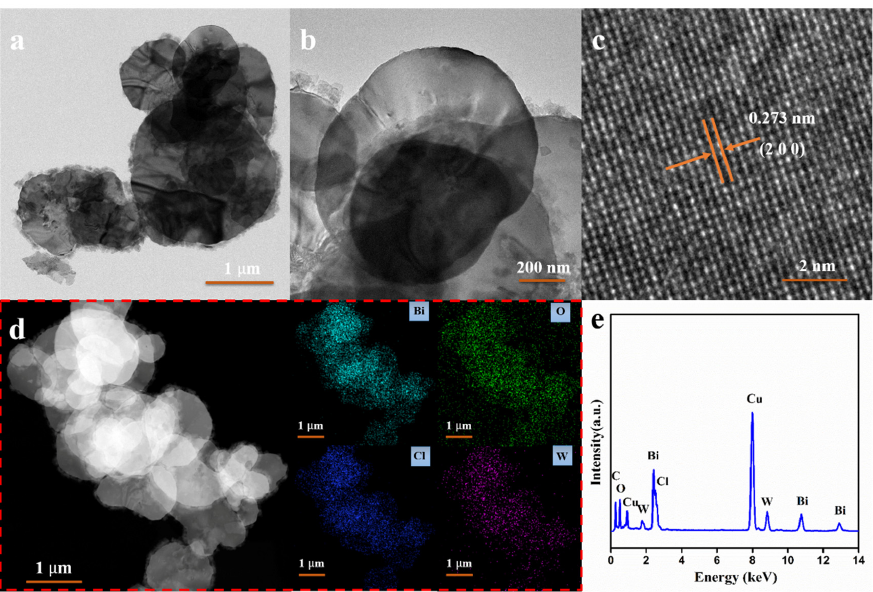
Figure 4. TEM ( a , b ) and HRTEM ( c ) images, elemental mapping images ( d ) and EDS spectrum ( e ) of BC-3 nanocomposites. The XPS spectra of the samples are illustrated in Figure 5. As exhibited in Figure 5a, the survey scan spectra indicate that BC-3 nanocomposites are mainly composed of Bi, O,